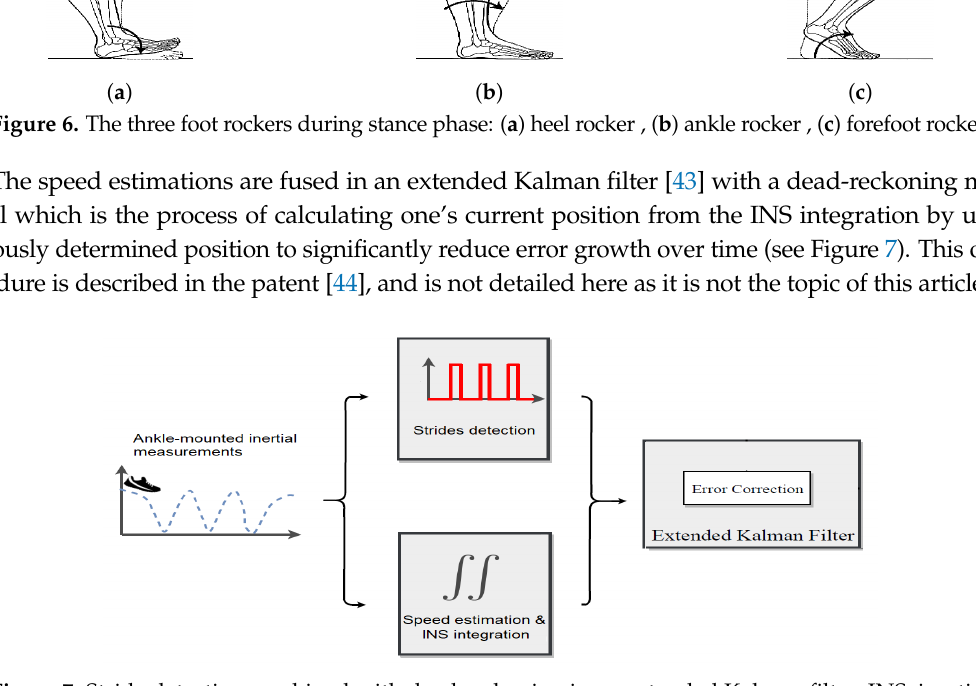
Figure 7. Stride detection combined with dead reckoning in an extended Kalman filter. INS: inertial navigation